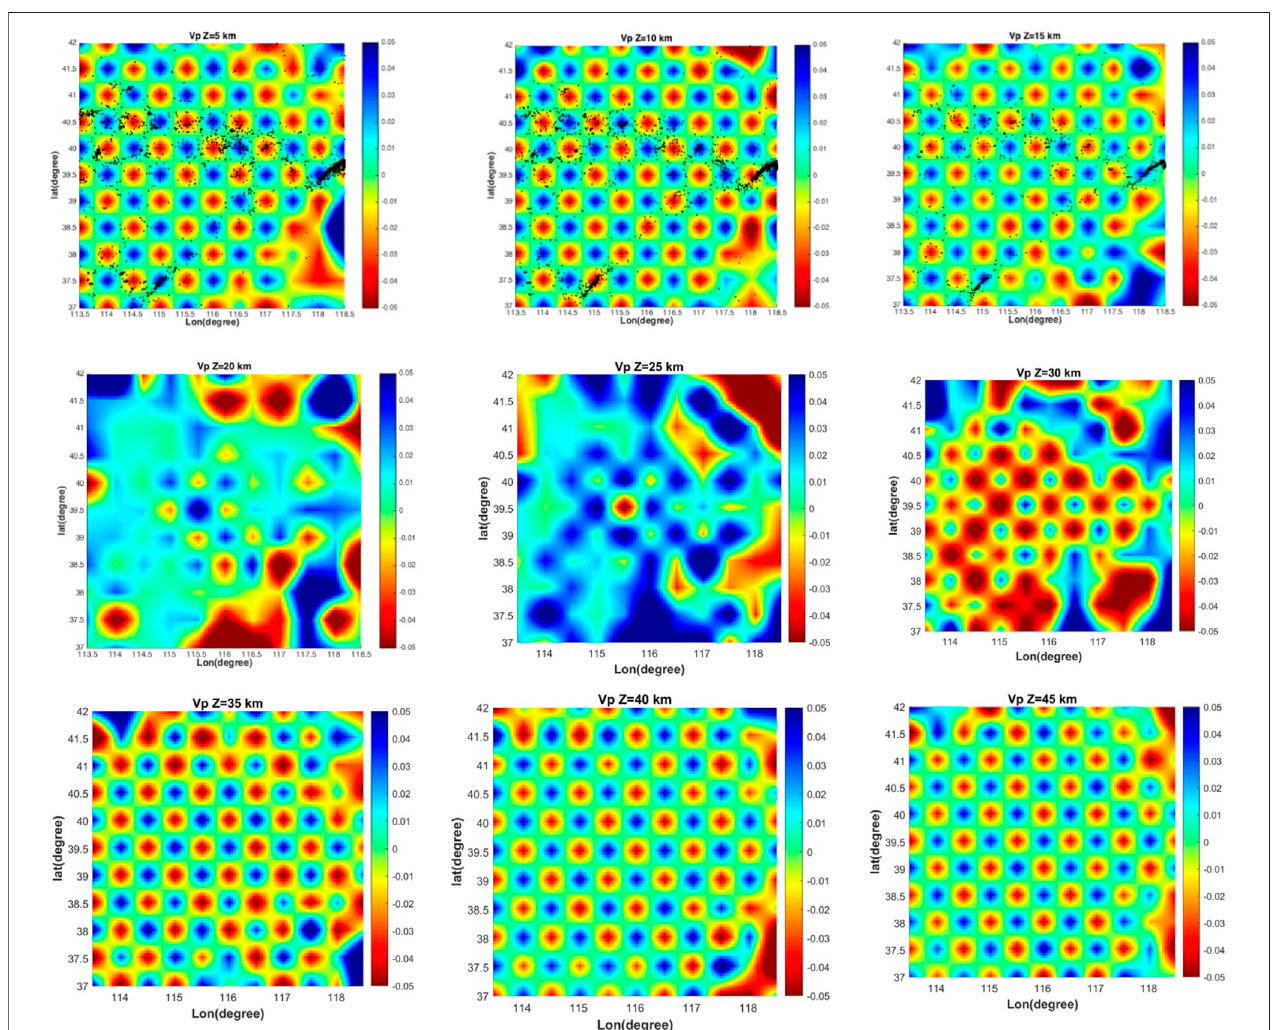
FIGURE 5 | Results of the P-wave checkerboard resolution test. The depth of the layer is shown on the top of each map.